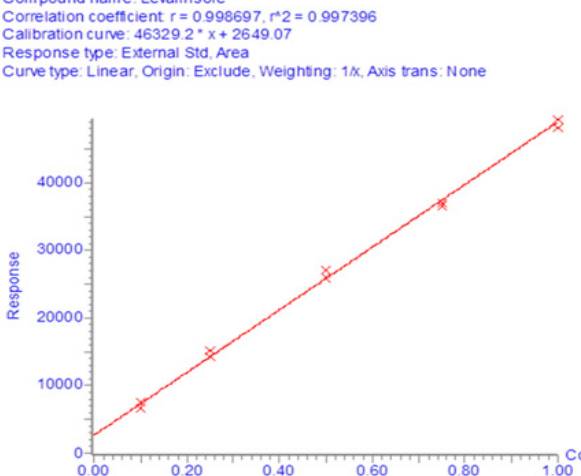
Figure A8. Chromatogram of the treated chicken kidney sample 24 h after treatment.